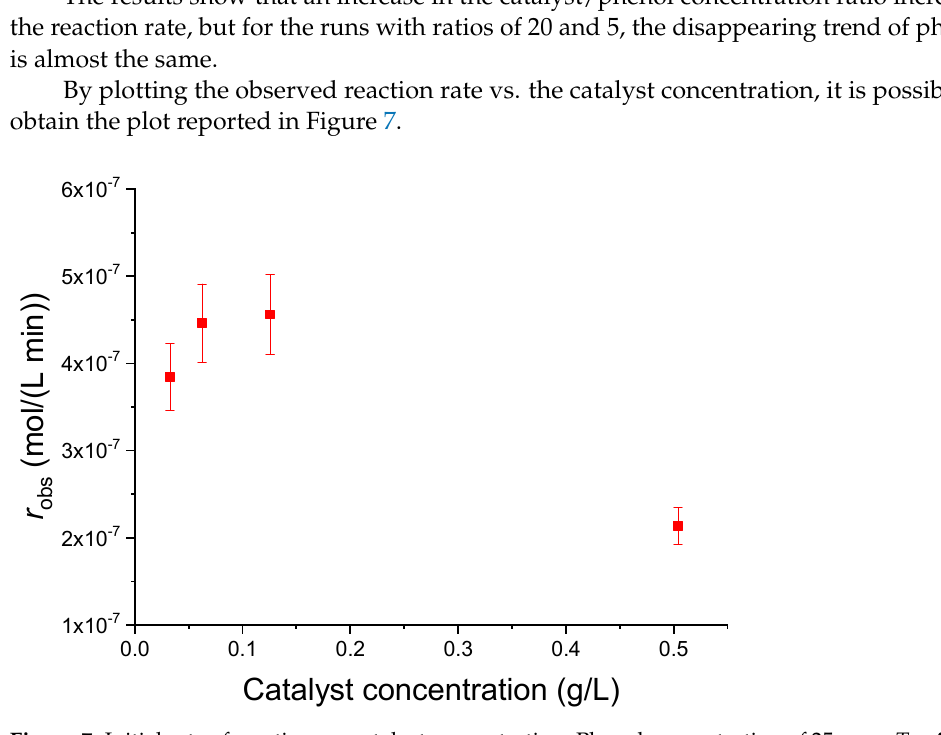
Figure 7. Initial rate of reaction vs. catalyst concentration. Phenol concentration of 25 ppm, T = 40 °C.